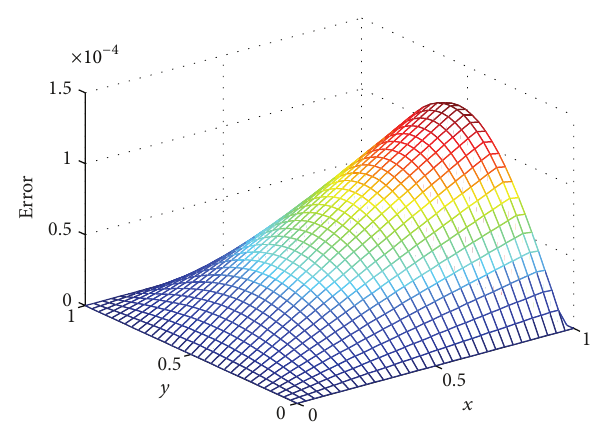
Figure7:ErrorsofEDSforExample10with 𝜖 = 0.01, ℎ = 𝑘 = 1/32